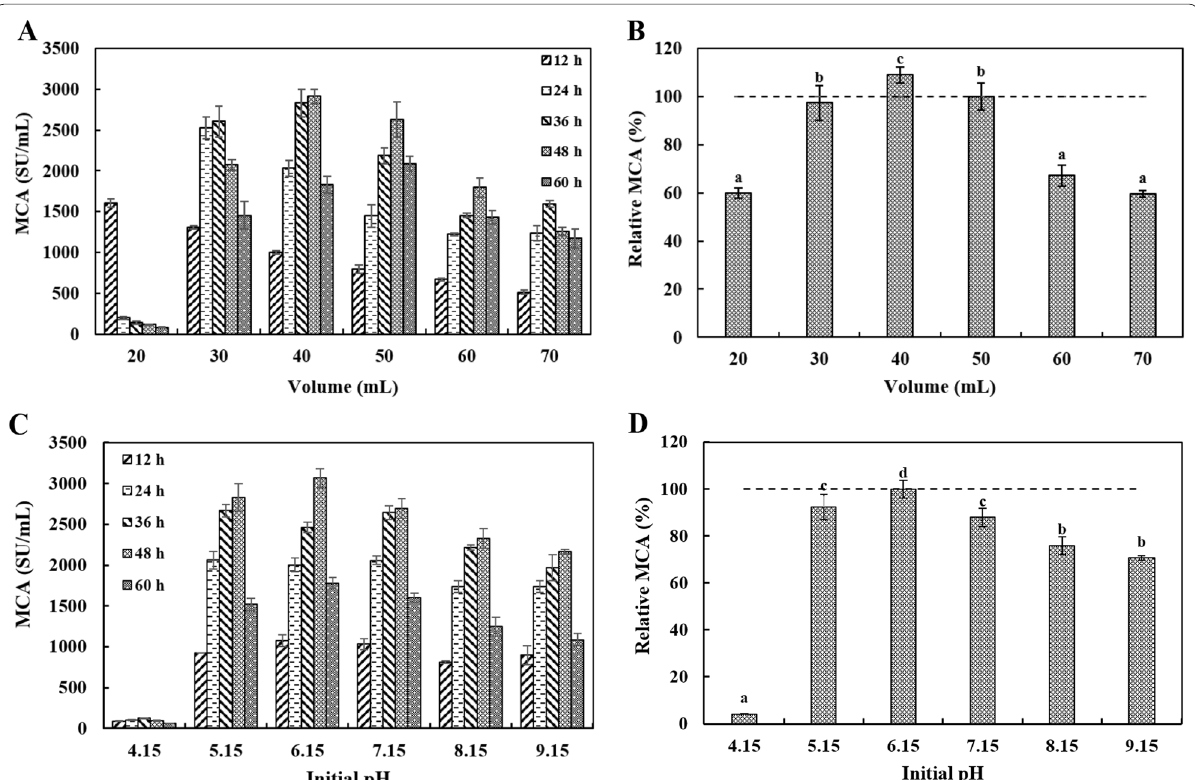
Fig. 7 The effects of volume (A and B) and initial pH (C and D) of fermentation medium on DB219 MCE production during different fermentation times (12–60 h). The medium composition was wheat bran (60 g/L), soluble starch (12.5 g/L) and corn steep liquor (3 g/L). a − d Values in the same row with different superscripts are significantly different ( P < 0.05). The data are represented as mean